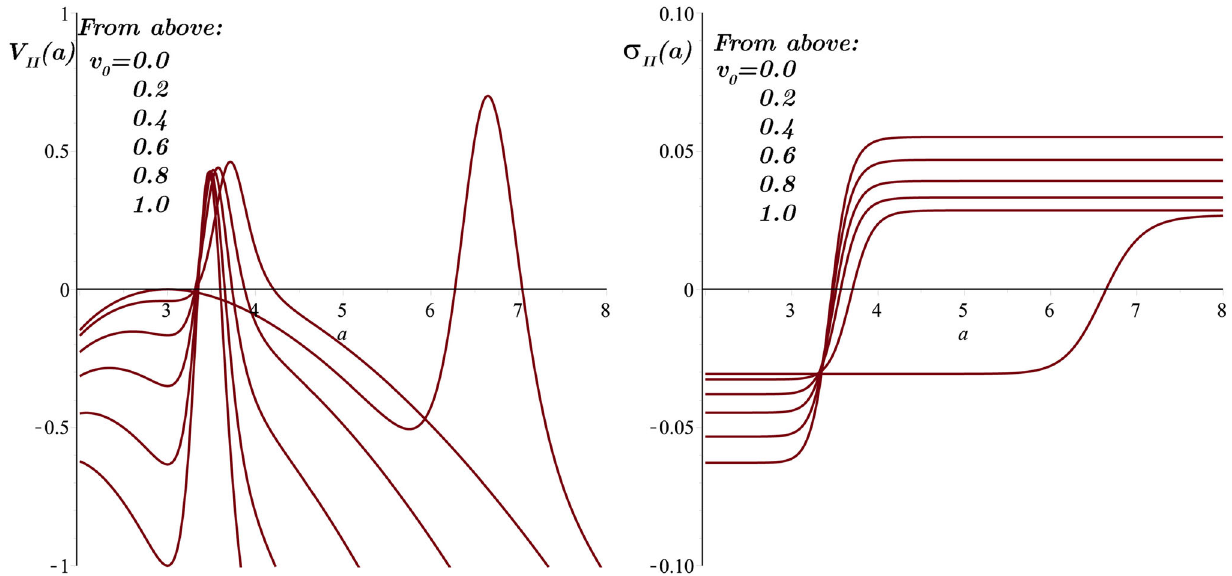
= − 16, M = 1 turbation to the positive direction makes the STSW oscillating about a 0 new stable point. This stability is a new observation which has not been detected before in linear stability analysis